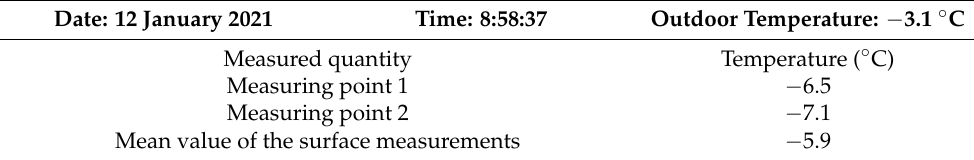
Table 4. Temperature values on the surface of the external wall, obtained using the thermographic camera.